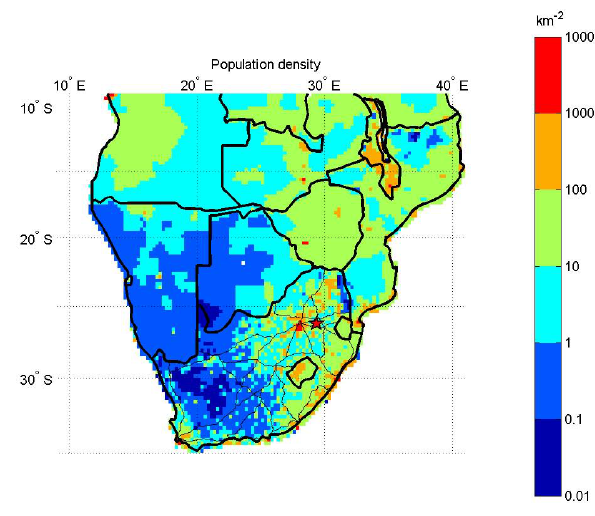
Fig. 2. Population density over southern Africa (CIESIN, 2010). In South Africa the main national roads are also shown. The measure- ment site is indicated with a red star. The population hot-spot west of the measurement site is the Gauteng metropolitan area consisting of Pretoria, Johannesburg and the Vaal Triangle.